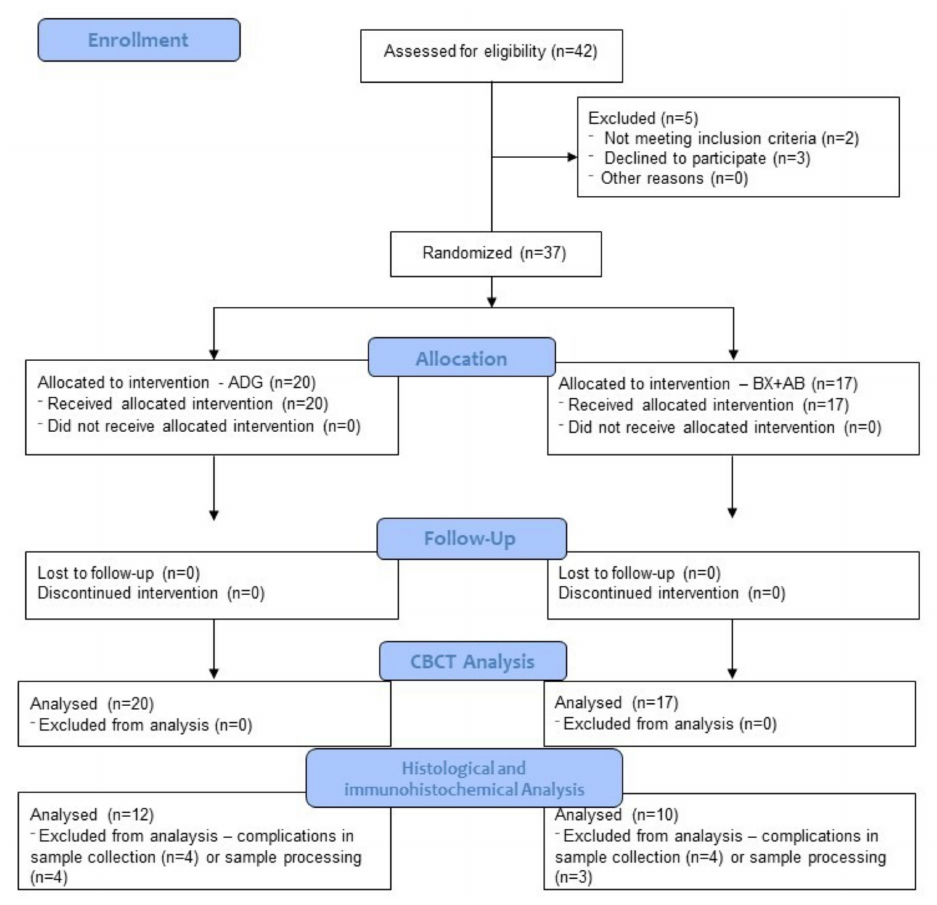
Figure 3. CONSORT